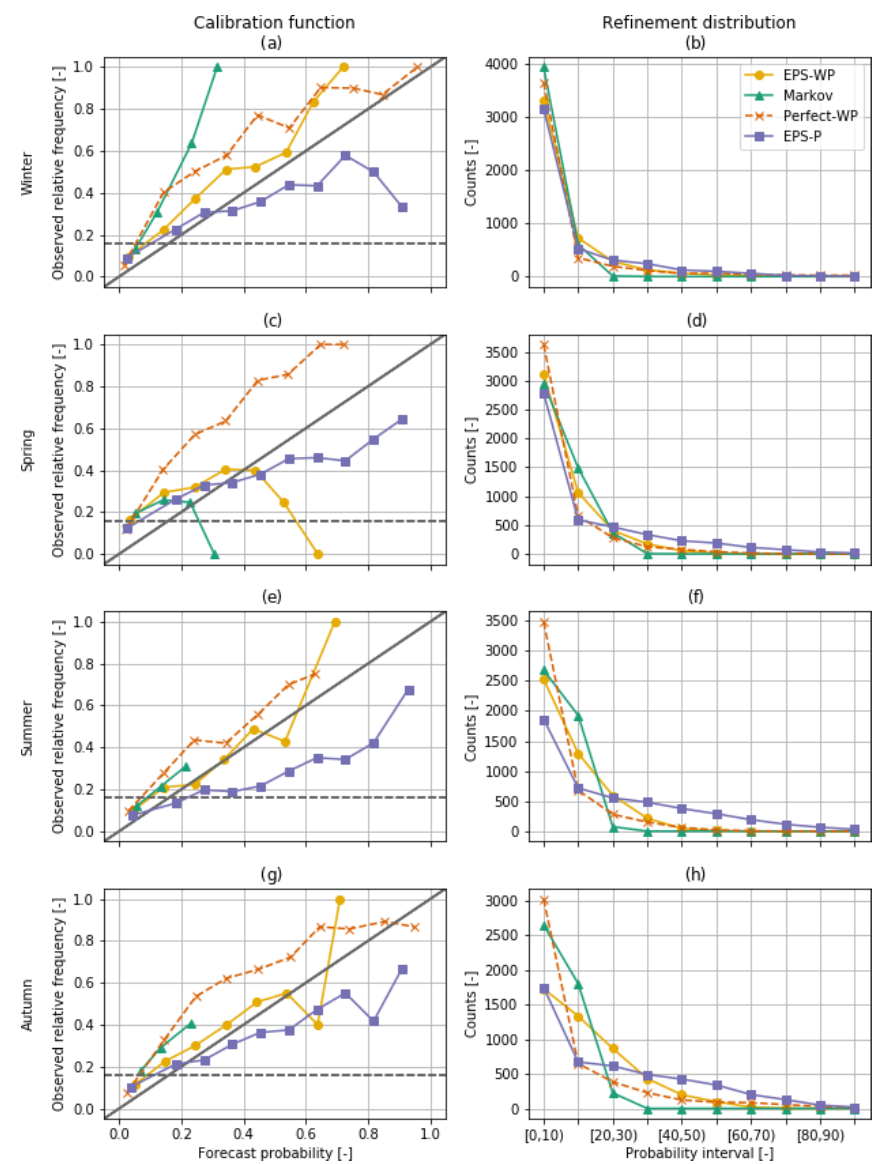
Figure 11. As Fig. 10 but for moderate drought (event relative frequency of